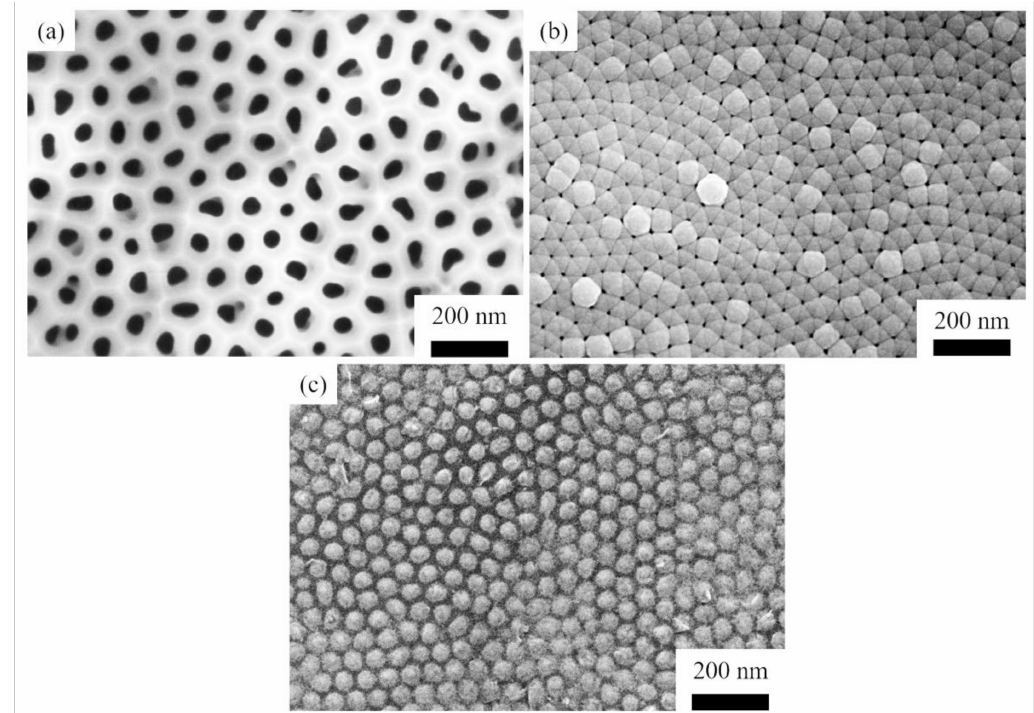
Figure 1. The morphology of SiC nanoarrays at each stage of the preparation process: ( a ) porous AAO template on graphite substrate; ( b ) amorphous SiC films in the holes of AAO; ( c ) SiC nanoarrays after removing AAO.